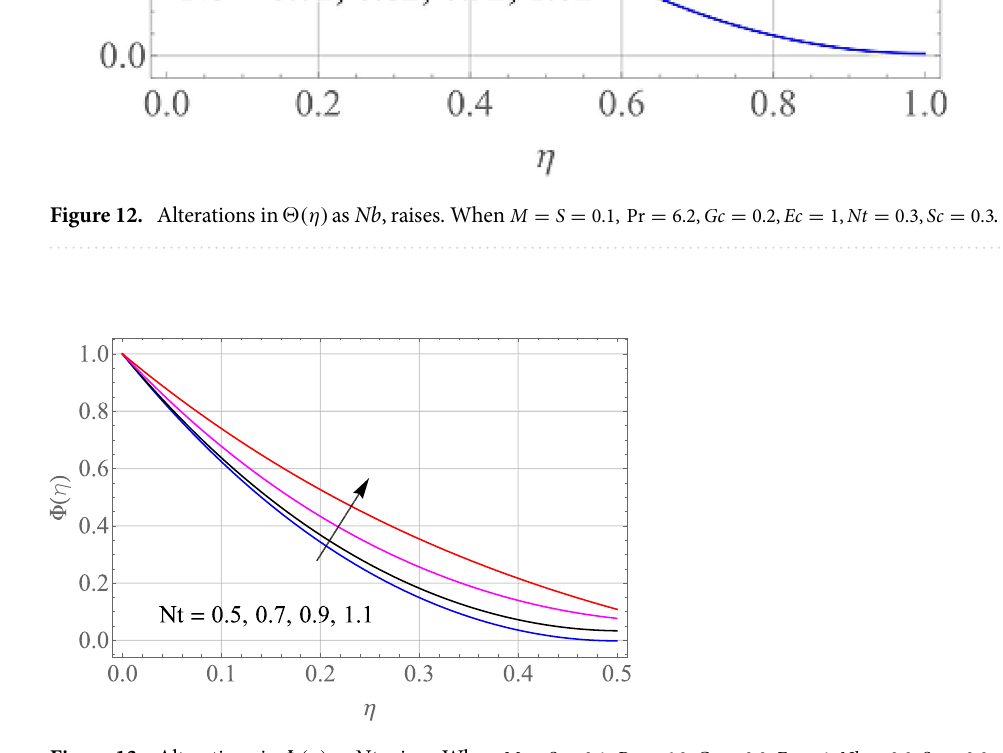
Figure 13. Alterations in �(η) as Nt raises. When M = S = 0.1, Pr = 6.2, Gc = 0.2, Ec = 1, Nb = 0.3, Sc = 0.3